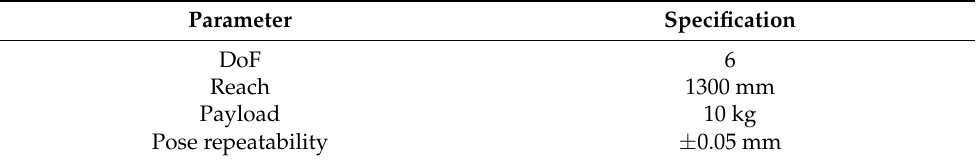
Table 1. Basic parameters of the UR10e robot.